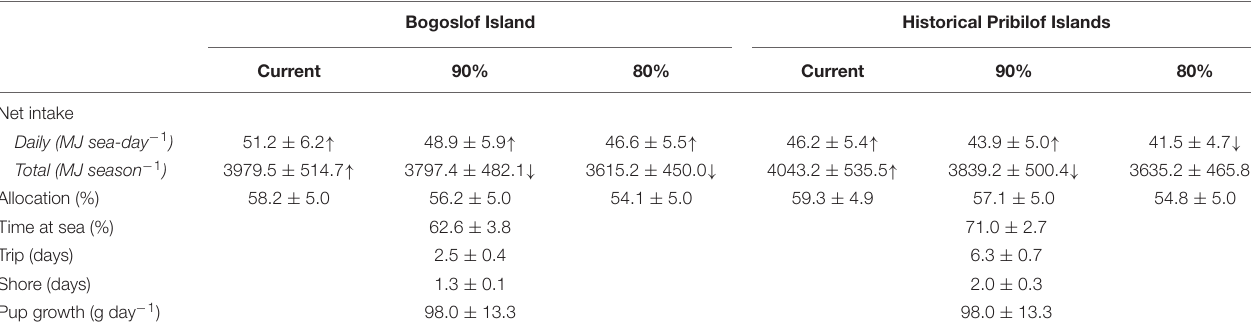
TABLE 3 | Summary of bioenergetic model simulations for the Bogoslof and Historical Pribilof scenarios, including mean ( ± SD ) net energy intake, the percentage of total net energy intake allocated to a female’s metabolic overhead (Allocation), percentage time at sea, trip and shore durations, and pup growth